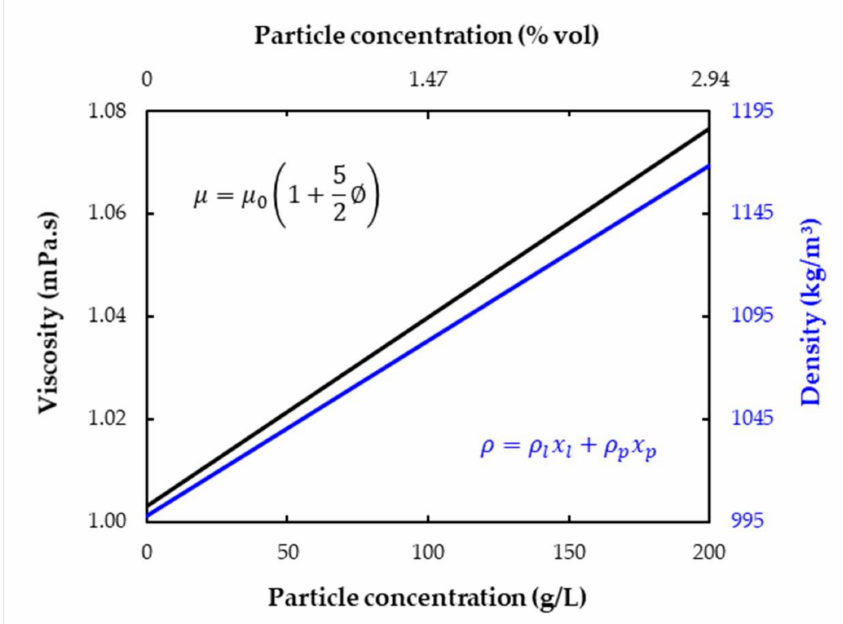
Figure 8. Variation of the viscosity and density of the liquid suspension due to the particle concentra- tion; the liquid viscosity is calculated with the Einstein